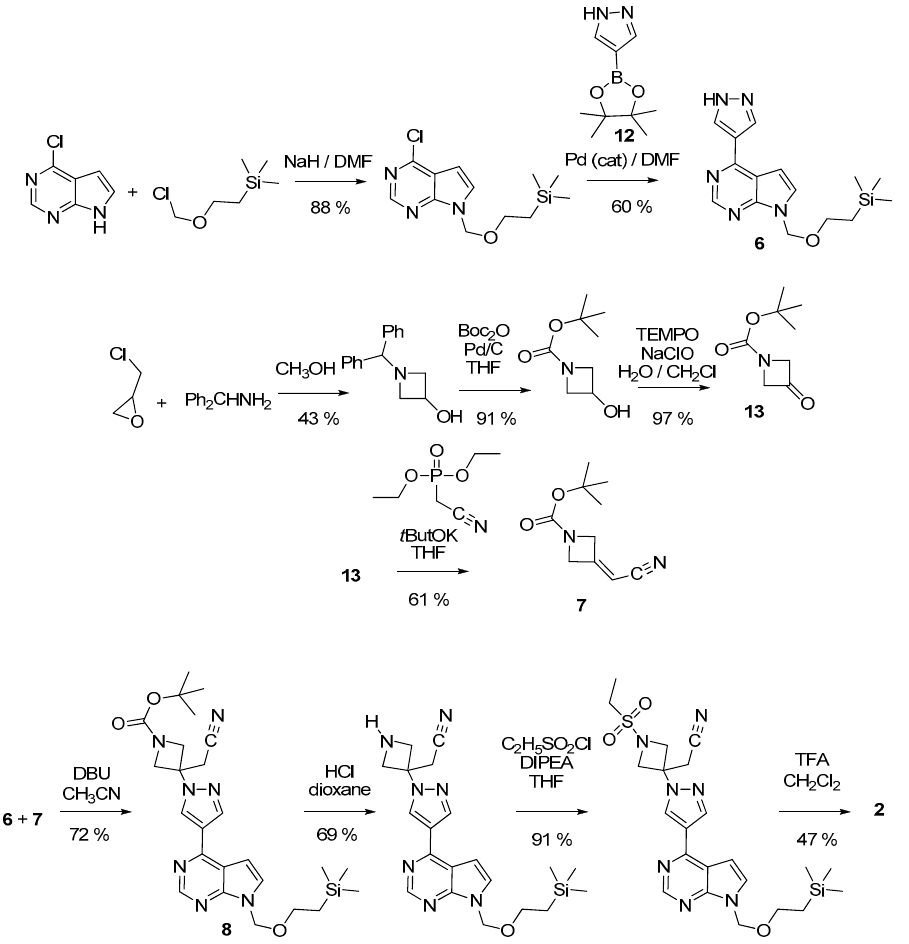
Scheme 1. Key steps in two alternate routes yielding baricitinib 2 .